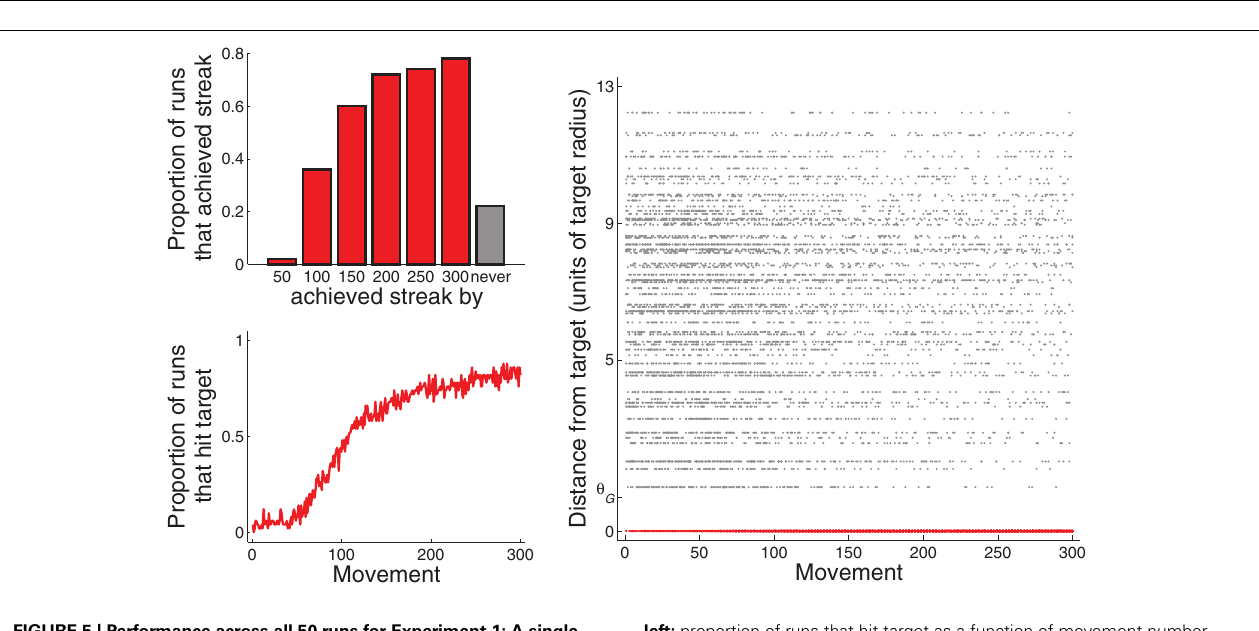
left: proportion of runs that hit target as a function of movement number. Right: Distance from the center of the target (in units of target radius) of each movement from all 50 runs. That for movements that hit the target are drawn in red and are at value 0 of the vertical axis.